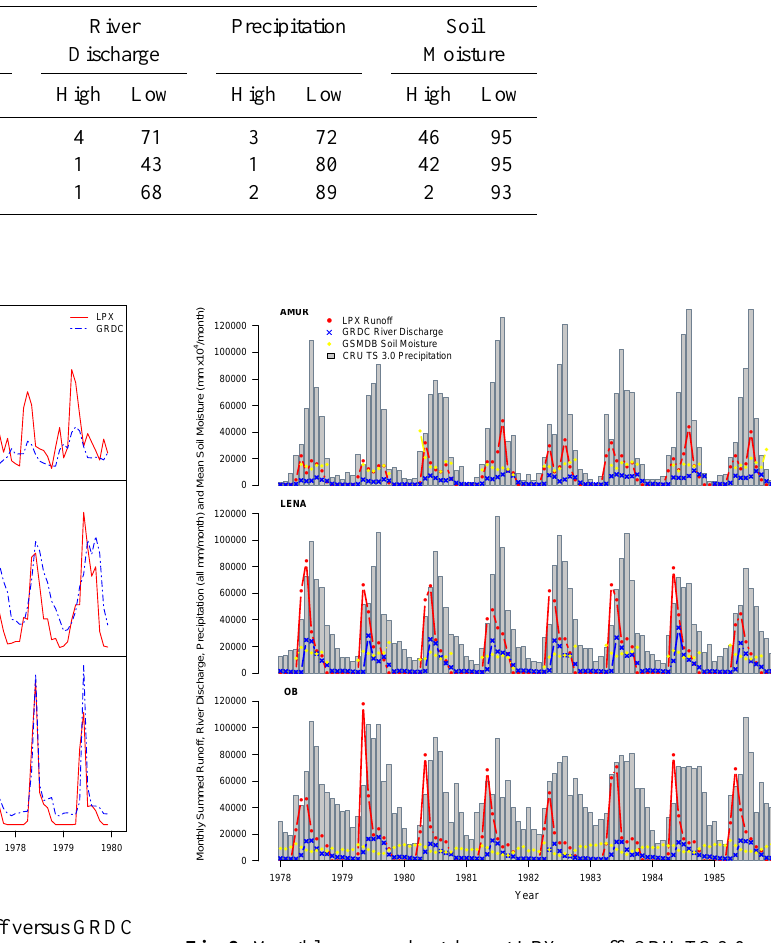
Fig. 8. Monthly summed catchment LPX runoff, CRU TS 3.0 pre- cipitation, GRDC river discharge (all mmmonth − 1 ) and Global Soil Moisture Data Bank (GSMDB) soil moisture (mm × 10 4 /month) for the Amur, Lena and Ob catchments between January 1978 and December